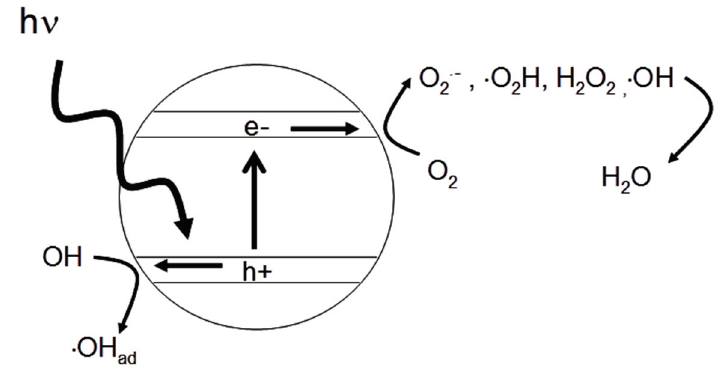
Figure 2. Schematic of photocatalytic mechanism on a titanium dioxide particle leading to the production of reactive oxygen